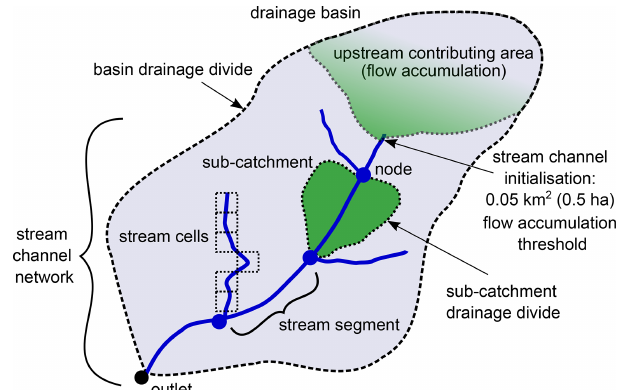
Figure 1. Schematic overview of the terminology used in Hydrog- raphy90m. See the main text for detailed